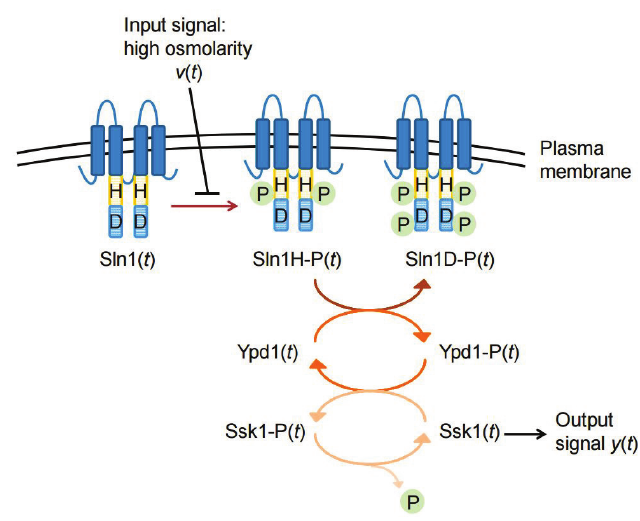
Figure 1. Schematic representation of phosphorelay